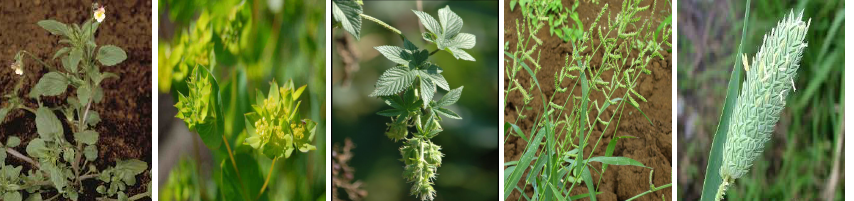
Figure 2. From left to right: Chickweed, Cleaver, Cockleblur, Crowfoot, Fat-hen (Source: [41]).